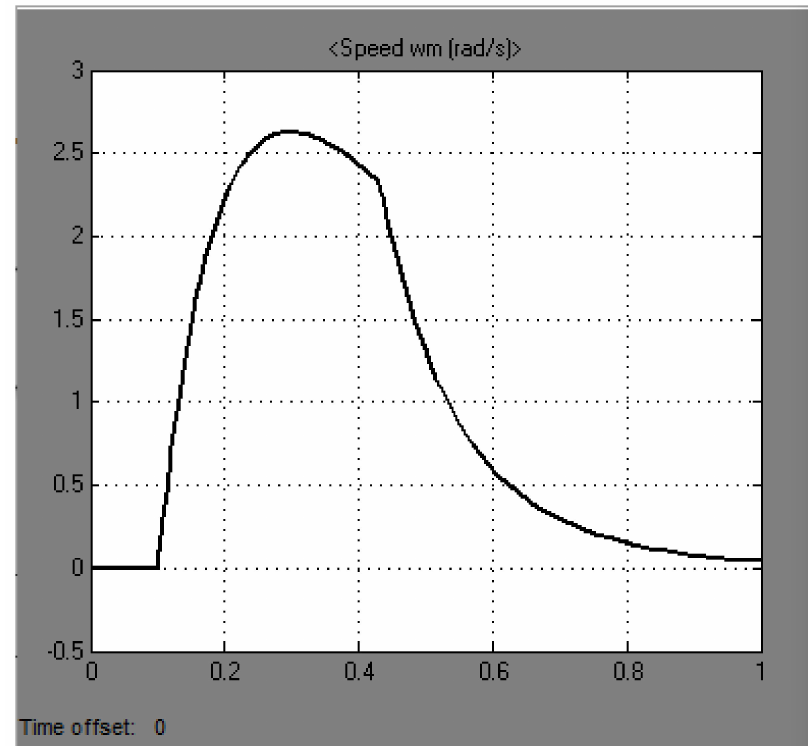
Figure 9. Speed when moving from one stop to another.